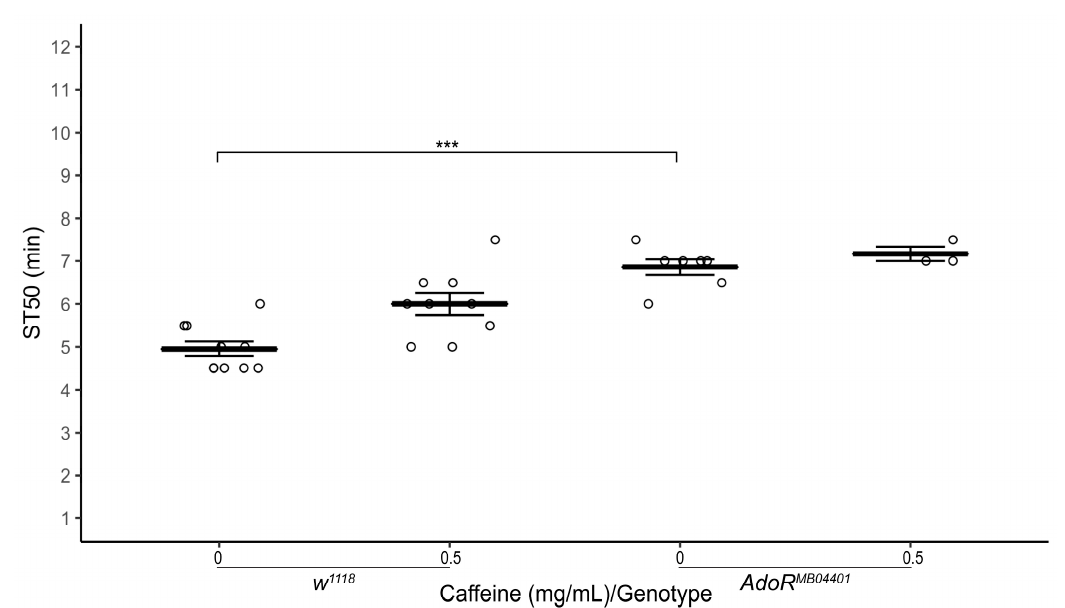
Figure 5. Effect of adenosine receptor mutation on ethanol-induced sedation. Comparison of ST50 when exposed to 100% ethanol of 1–3 day old male adenosine receptor mutant flies ( AdoR MB04401 /TMC, Sb ) and w 1118 flies raised for three days on (0 mg/mL and 0.5 mg/mL) caffeine- supplemented food. Heterozygous AdoR mutant flies ( AdoR MB04401 / TM6C, Sb ) raised on control food and 0.5 mg/mL caffeine-supplemented food have a significantly higher ST50 than w 1118 flies raised on control ( p < 0.001) and 0.5 mg/mL caffeine-supplemented food ( p = 0.004), respectively. Horizontal bars represent the mean ST50 ± standard error of 3–9 biological replicates. For each sedation assay 8–10 male flies were used (circles). *** p < 0.001; two-tailed independent samples t -test.